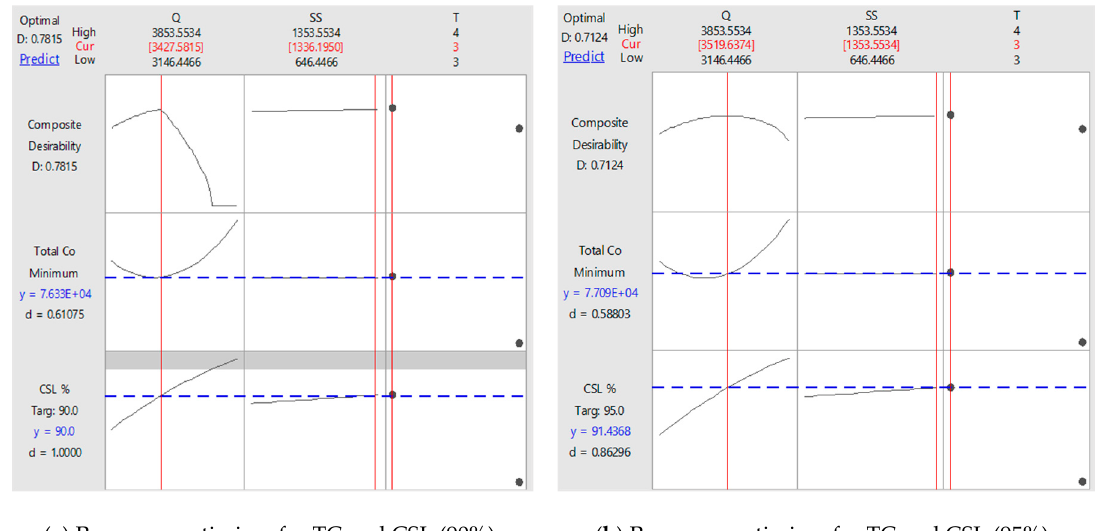
Figure 13. CCD—response optimizer for TC and CSL.